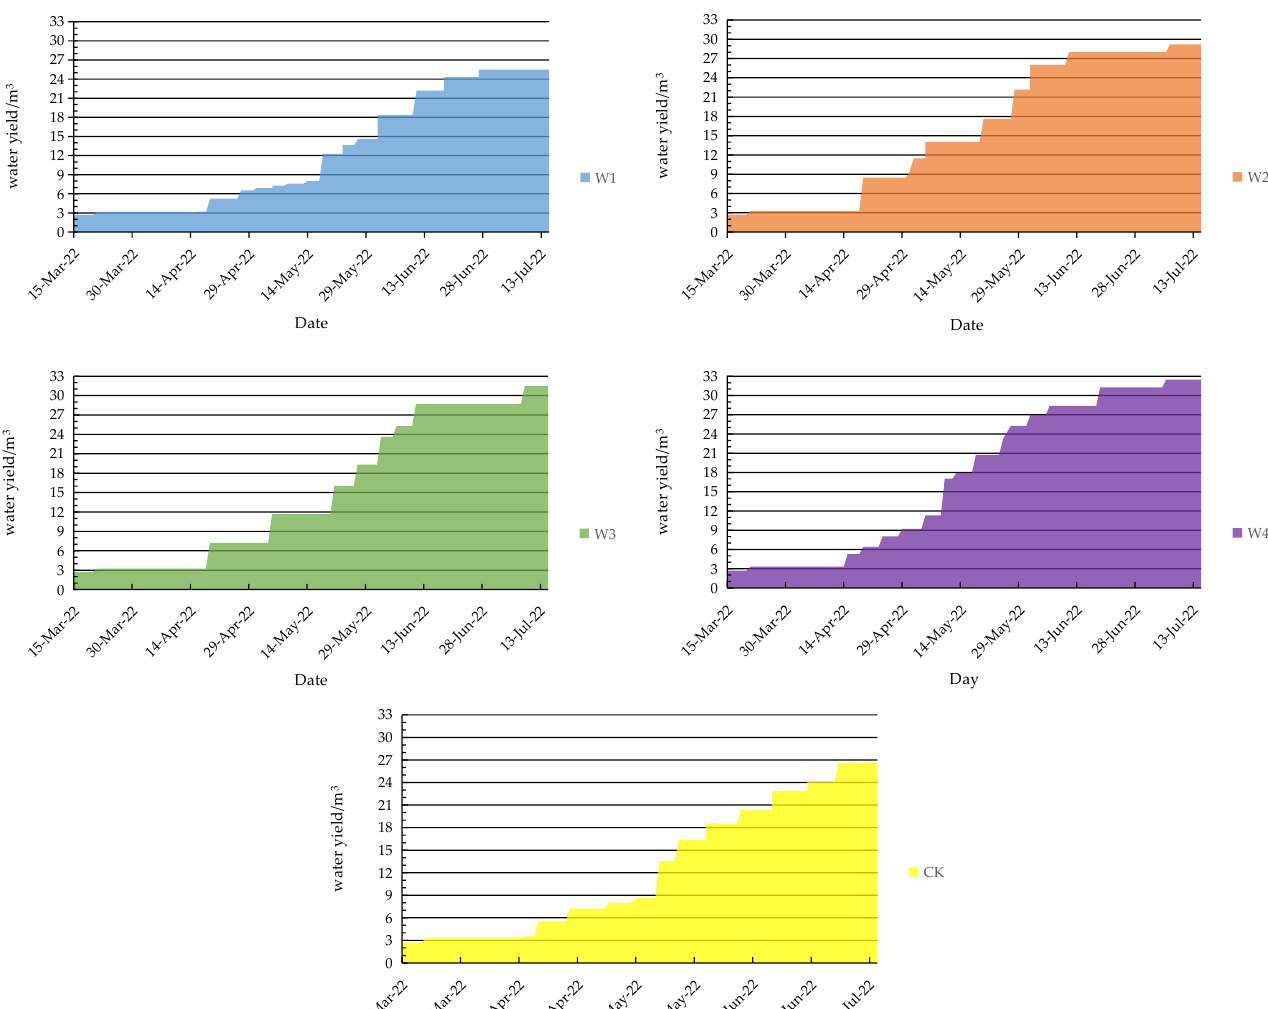
Figure 5. Cumulative daily water usage curves for different treatments.